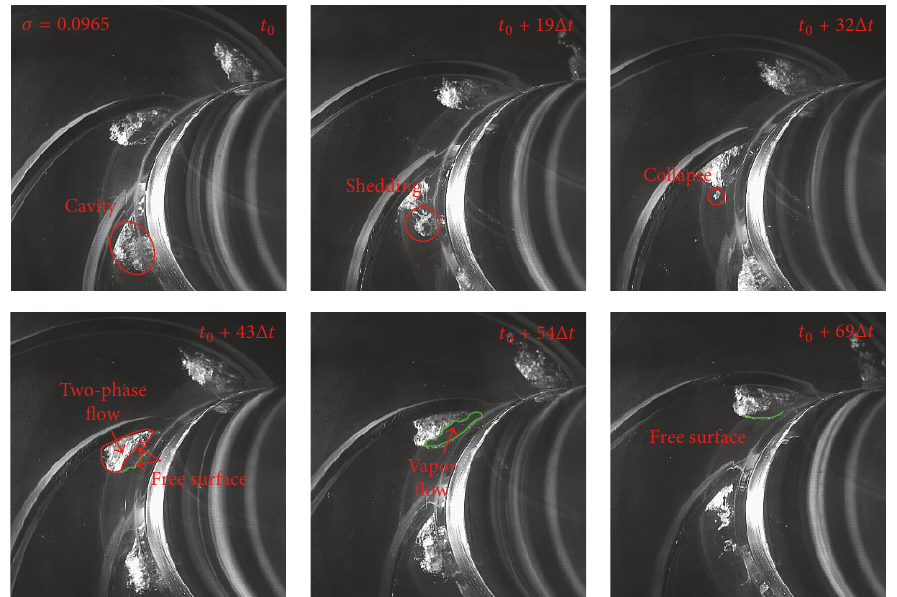
Figure 14: Cavitation developing process at cavitation number 𝜎 = 0.0965